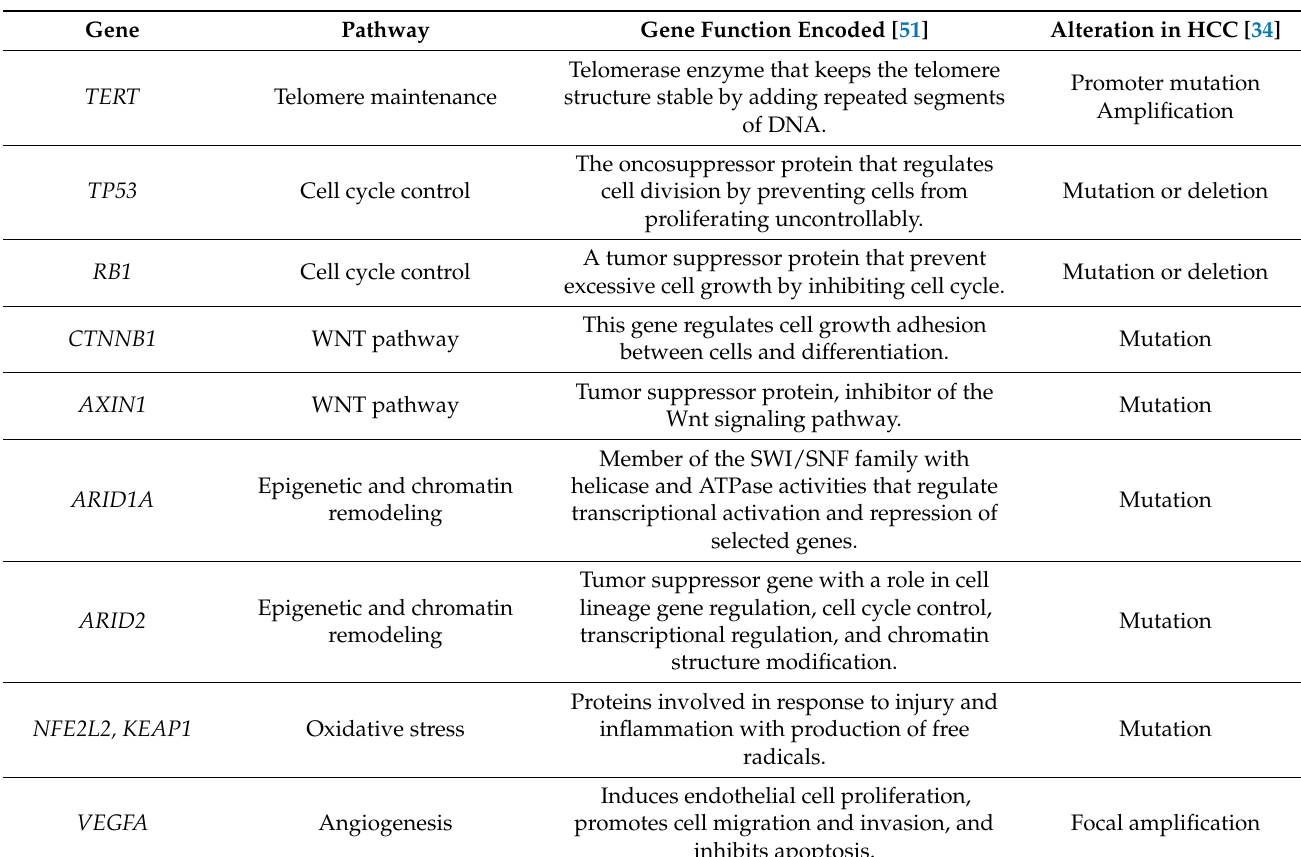
Table 1. Main gene alterations in